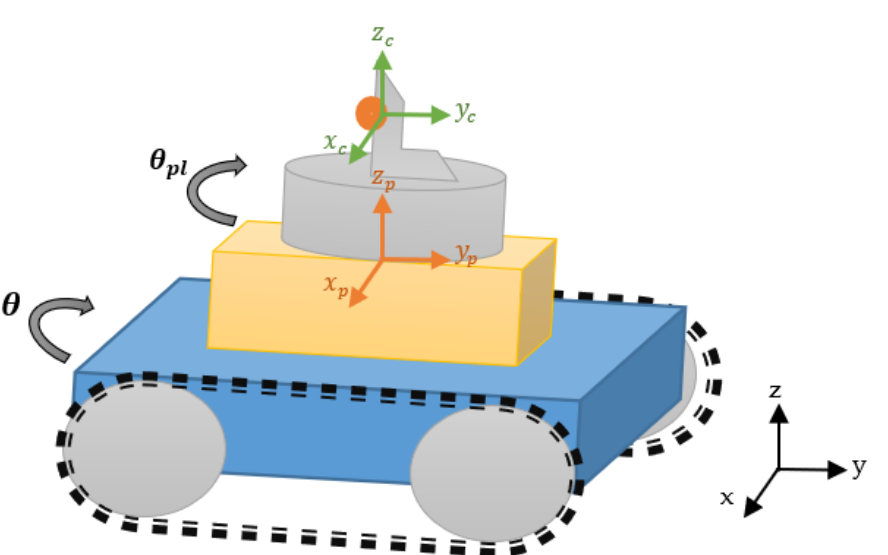
Figure 1. Hilare-type robot of three degrees of freedom (3 DOF), using the kinematic model.